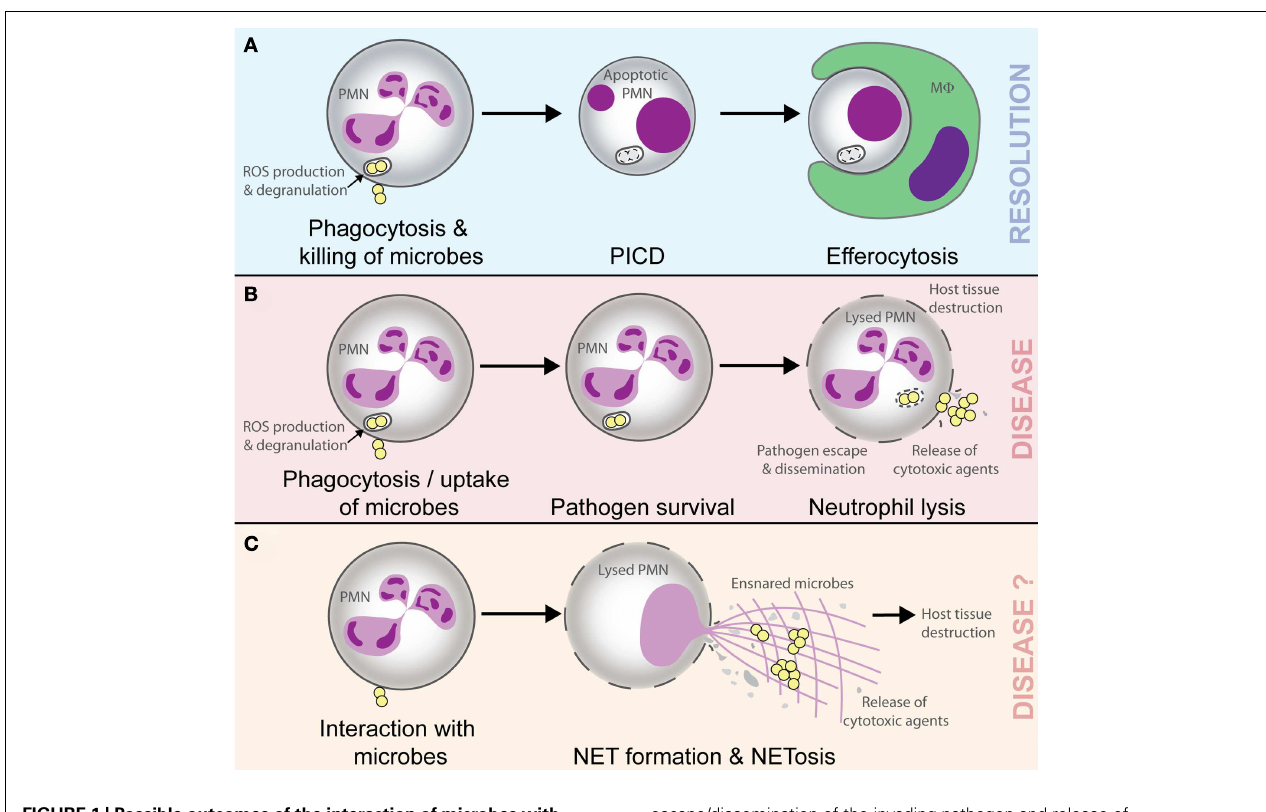
FIGURE 1 | Possible outcomes of the interaction of microbes with neutrophils. Phagocytosis and killing of microorganisms by neutrophils (polymorphonuclear leukocyte, PMN) triggers host cell apoptosis and ultimate removal by macrophages (M Φ ) or dendritic cells.This process promotes resolution of the inflammatory response (A) . Pathogenic microbes such as Staphylococcus aureus can cause lysis of PMN after phagocytosis, thereby facilitating